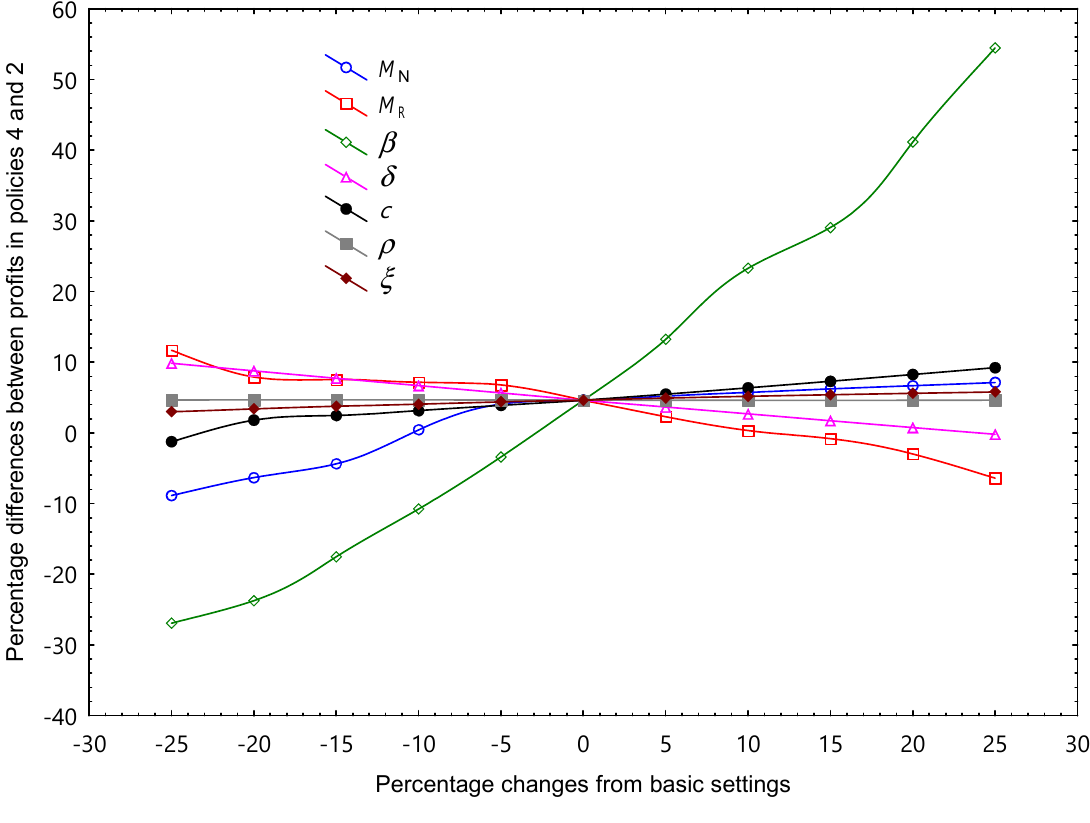
Fig. 1. Impact of key parameters on profit growth: policy 4 vs. policy